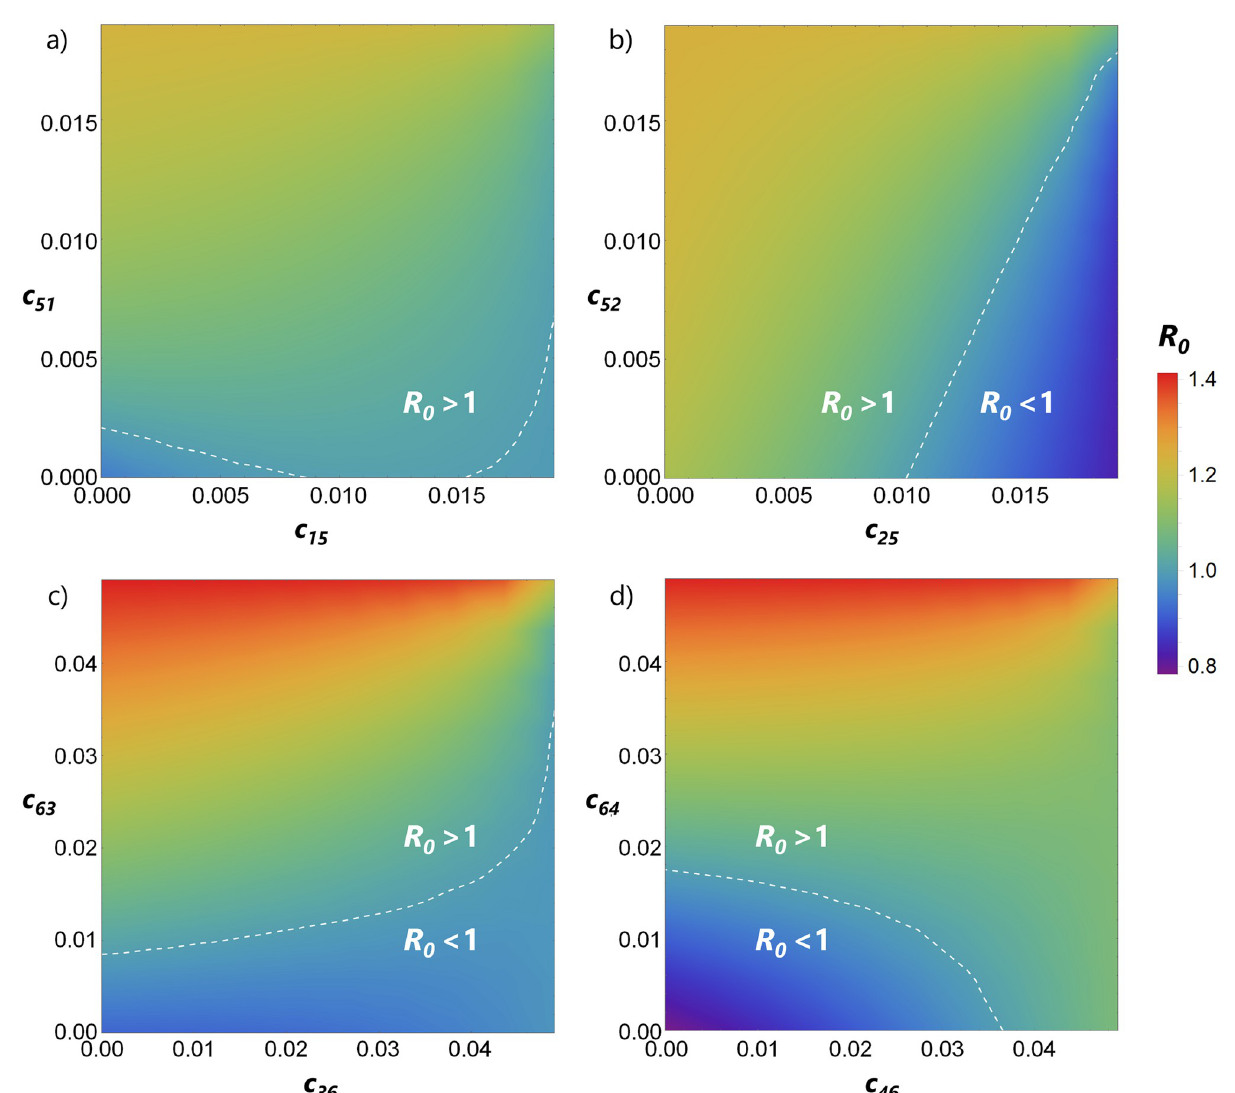
Fig 6. Non-competent species have a general dilution effect, but the impact of their competitive pressures on R 0 differ for vectors and for hosts. (a) and (b) interspecific competition with non-competent vector N 5 , (c) and (d) interspecific competition with non-competent host N 6 . In all cases, R 0 is maximized when the competition strength against the non-competent vectors or non-competent hosts is the highest. All other parameters are fixed to the estimates in Tables 1 and